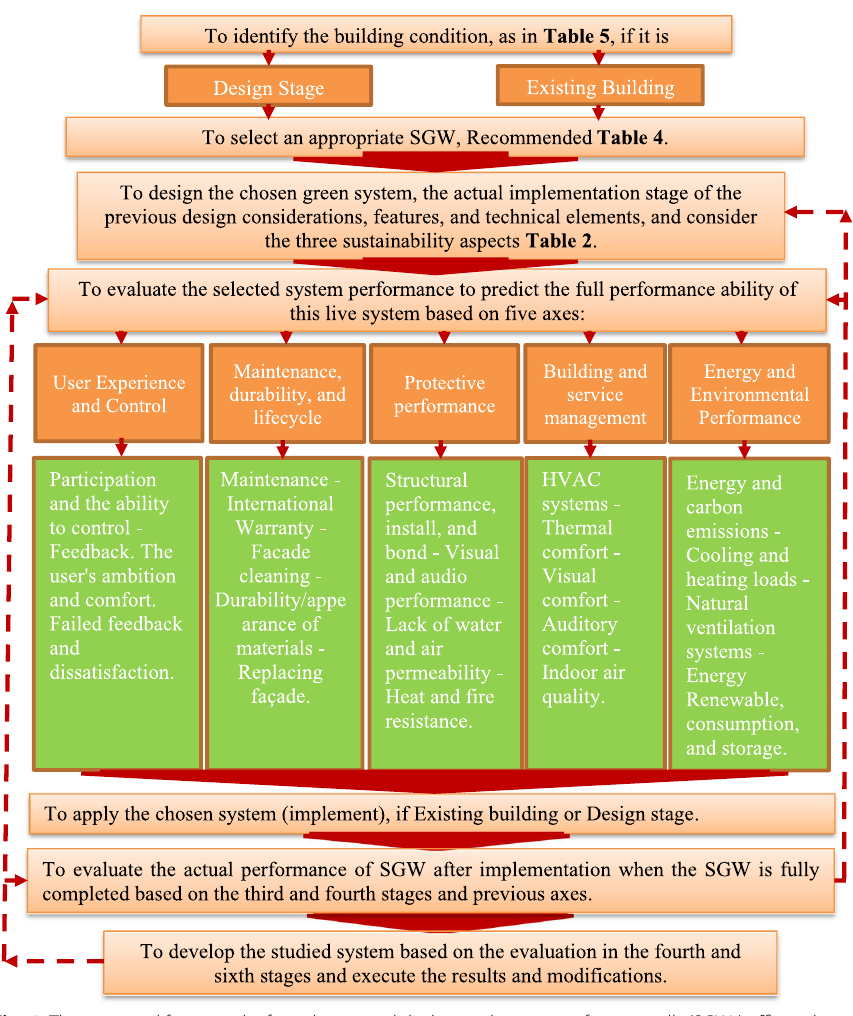
Fig. 6 The proposed framework of employing and dealing with systems of green walls (SGWs) efficiently to be the chosen system is the most suitable. The framework provides an implementation strategy for selecting and designing the most appropriate SGW for the circumstances and condition of the examined building, as well as a tool for implementing, evaluating, and working to improve SGW when it is